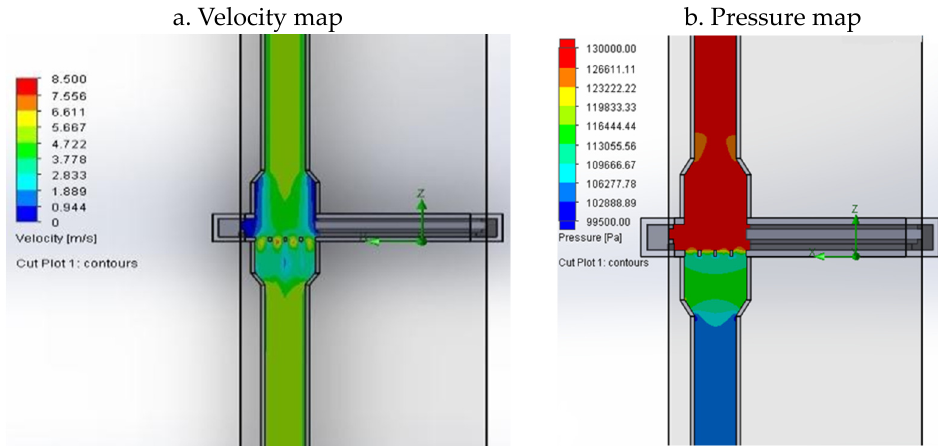
Figure 15. Second valve geometry with 100% opening.